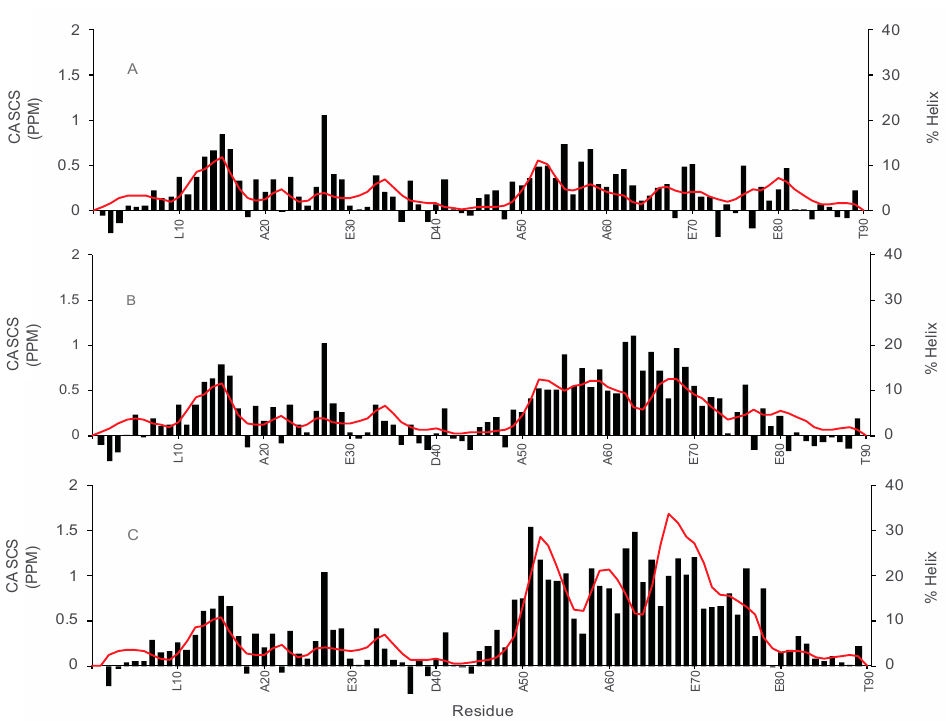
Figure 5. Residue-specific alpha carbon secondary chemical shift and % helix plot for COR15A WT and mutants in 0% TFE. Alpha carbon secondary chemical shifts (black bars) and % helix values (red line) measured using NMR experiments for COR15A WT and mutants in the absence of TFE are shown. The NMR experiments used include 1 H- 15 N HSQC, HNCACB and HNCO. The alpha carbon secondary chemical shifts are on the primary vertical axis and the measured % helix values are on the secondary vertical axis, while the residue number/position for every 10 residues is on the horizontal axis. ( A ): COR15A WT, ( B ): single mutant G68A, which has the glycine at residue 68 mutated to an alanine, ( C ): quadruple mutant 4GtoA, with glycine residues at positions 54, 68, 81 and 84 mutated to alanine residues.